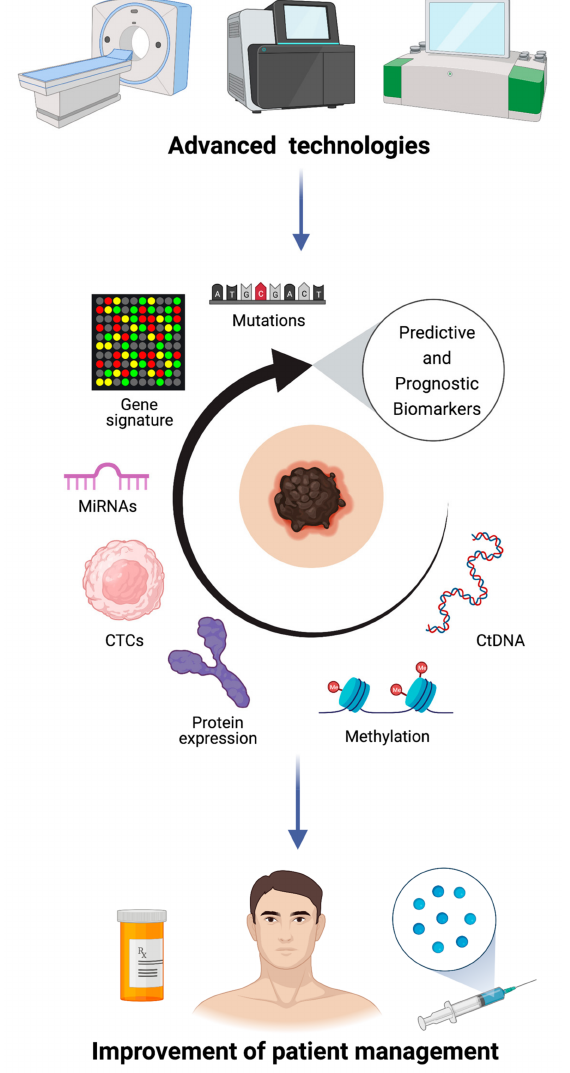
Figure 1. Role of biomarkers in stage III melanoma. Multi-omics approaches are crucial for personal- ized